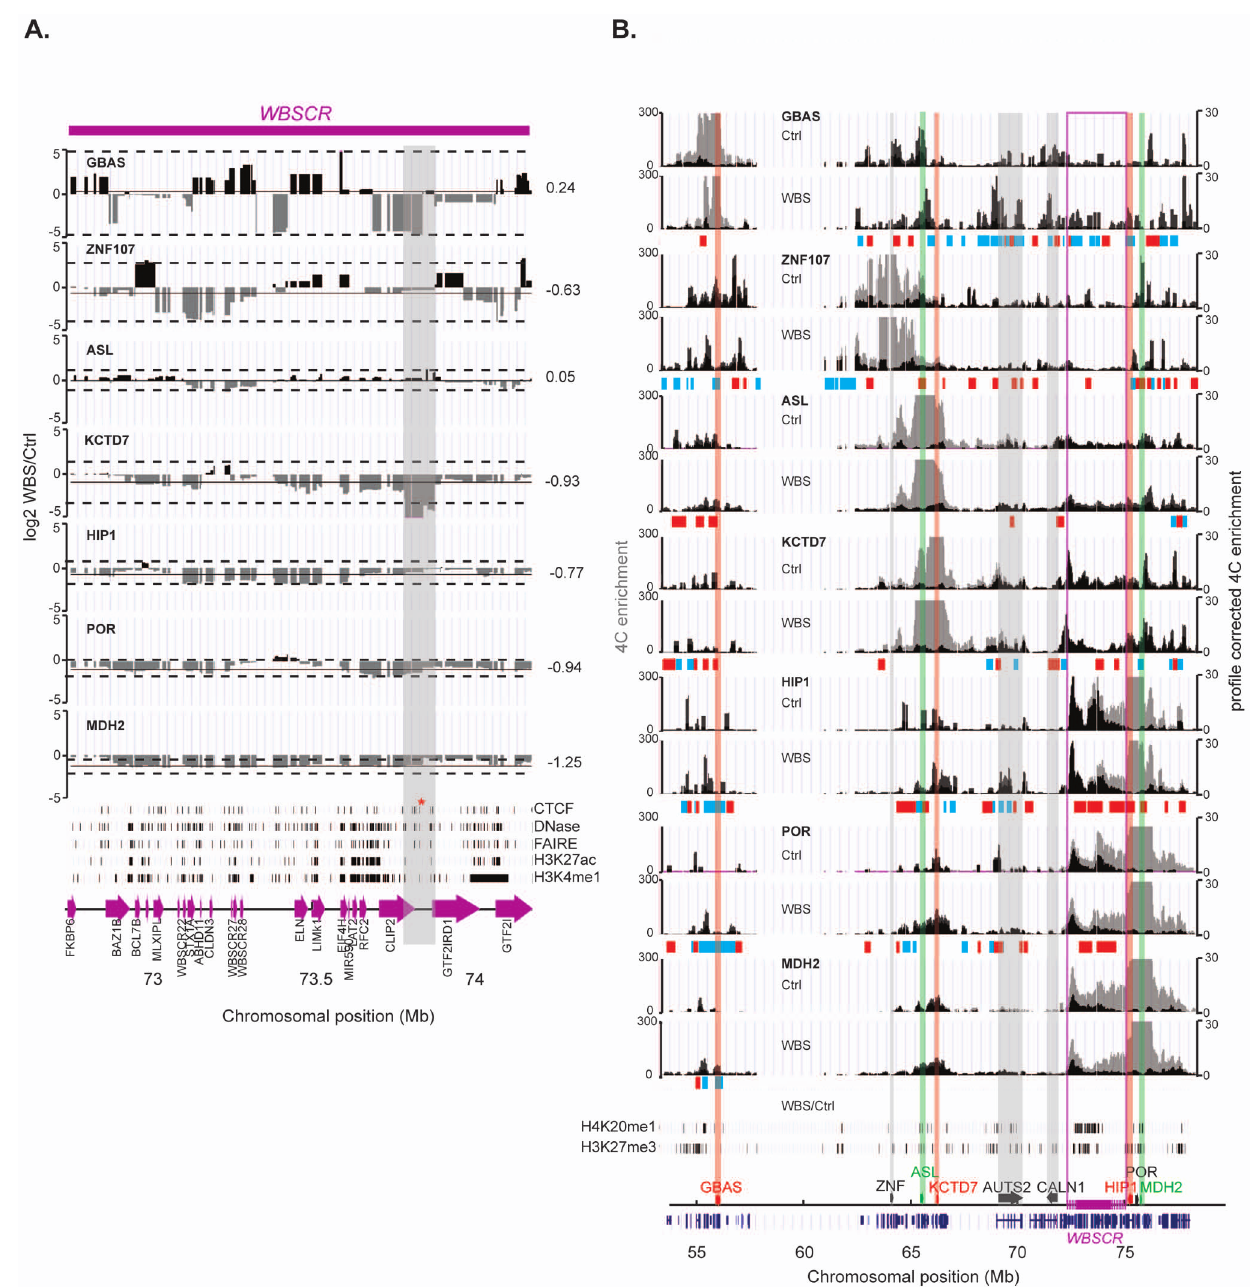
Figure 2. Modification of short-range interactions in WBS compared to control cells. ( A ) Close-up of the log2-fold interaction changes in WBS versus Ctrl within the WBSCR. The black line indicates the median of the changes within the WBSCR, which is also displayed at the right of each graph. The dashed lines show the 95% confidence interval. The positions of all genes are displayed at the bottom with purple arrows. The area highlighted in grey pinpoints the higher interactions in Ctrl cells between the KCTD7 viewpoint and the region around the CLIP2 and GTF2IRD1 genes. The black ticks below show the location of the five marks of regulatory regions in GM12878 cells (as found in the ENCODE data), including CTCF binding sites, DHSs, FAIRE sites, H3K27ac and H3K4me1 and binding sites, with one overlapping mark highlighted with a red asterisk. ( B ) Windowed 4C signal of each of the seven viewpoints in both Ctrl and WBS cells around the WBSCR (see the legend of Figure 1B for details about the structures outlined). The log2-fold change of the windowed 4C data in WBS over control cells was calculated, and the resulting positive or negative Bricks are indicated below each viewpoint graphs, by blue or red bars, respectively. The significant changes in histone marks (as defined by SICER) are plotted below by ticks. First, deletion of specific long-range regulatory elements within thus in the expression of their target genes. Concordantly, we the rearrangement, such as enhancers and/or boundary elements, detect alterations of intrachromosomal interactions (chromosomal can cause changes in their finely tuned regulatory function and looping) between expression-affected gene loci and the rearranged